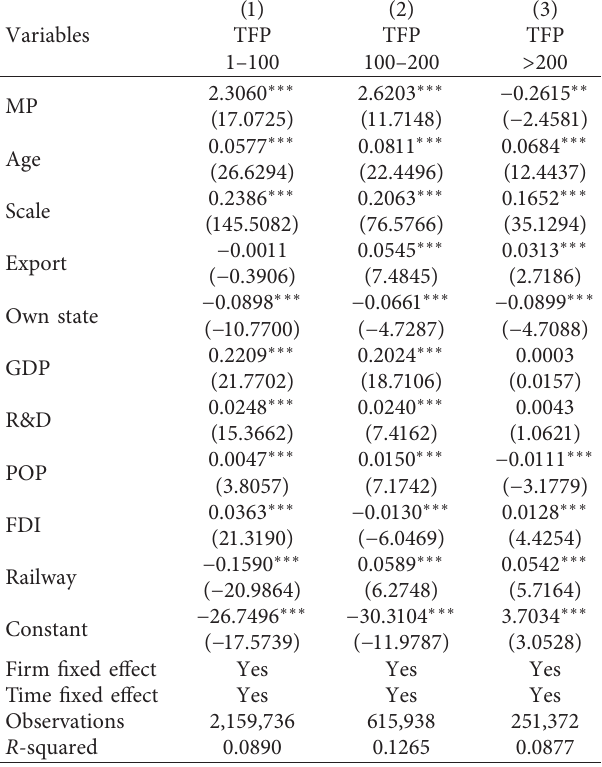
Table 14: Result of sample regression according to the relative centrality of Chinese cities.